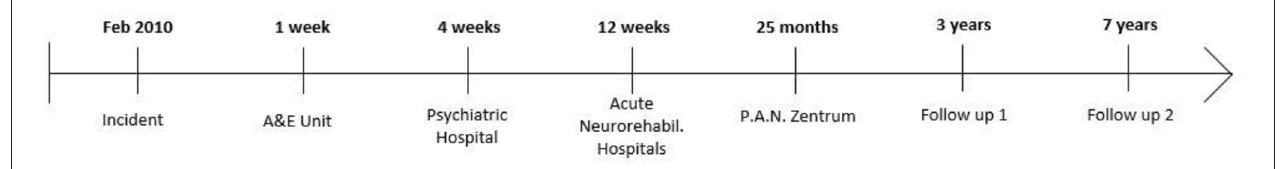
FIGURE 1 | Timeline of events illustrates the journey of his incident to 7-year follow-up.